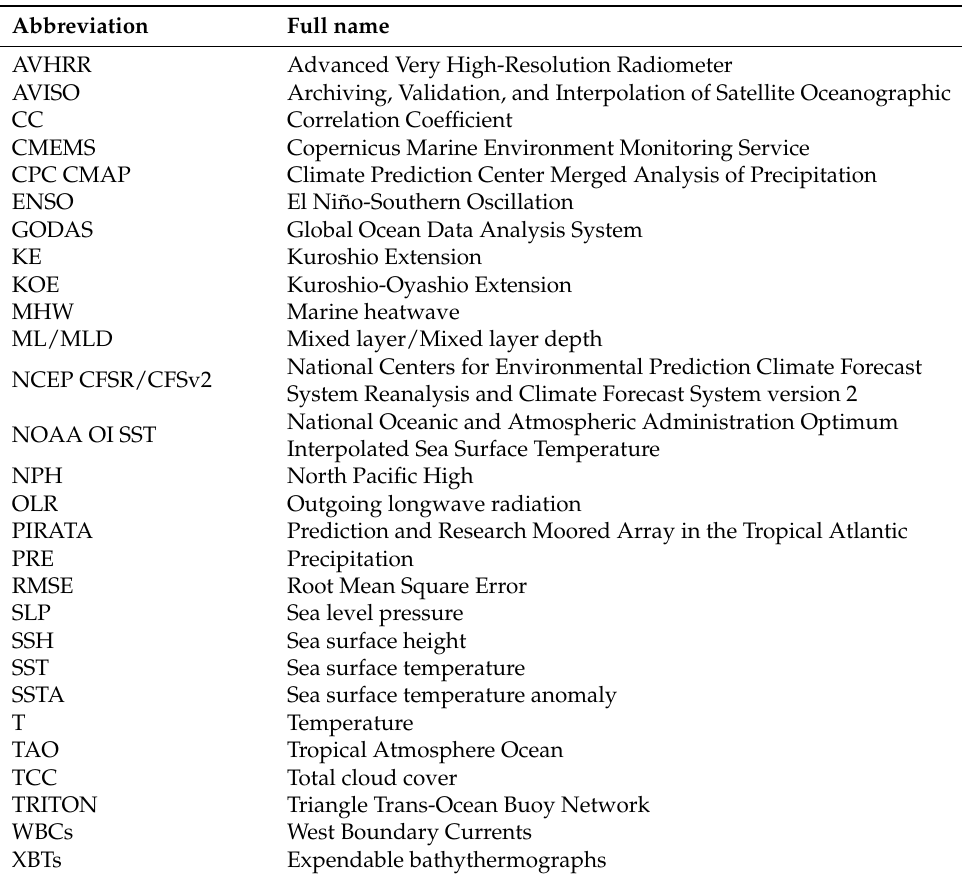
Table A1. List of English